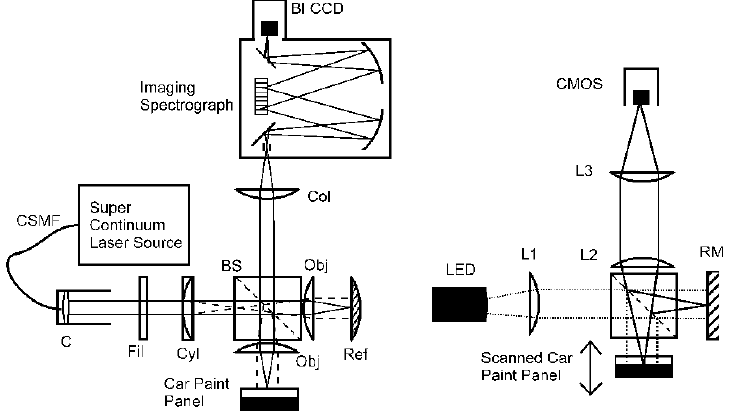
Figure 1. ( Left ) Line Field Optical Coherence Tomography (LF-OCT) setup. CSMF—Continuously Single Mode Fibre. C—Collimator, Fil—Optical Filters (Bandpass and Neutral Density), Cyl—Cylindrical Lens, BS—Cube Beam Splitter. Obj—Objective Lenses, Ref—Reference Interface (Flat glass surface), Col—Collection Lens, BI CCD—Back Illuminated Charged Couple Device camera (iVac, Andor, UK); ( Right ) FF-OCT setup, LED—Light Emitting Diode, L1, L2, and L3—Achromatic lenses, RM—Reference Mirror, CMOS—Complementary Metal Oxide Semiconductor camera (Point Grey, GS3-U3-23S6M-C). Table 1. Comparison of the specification of the LF and FF (full field) OCT devices, as used in the study. Performance Parameter